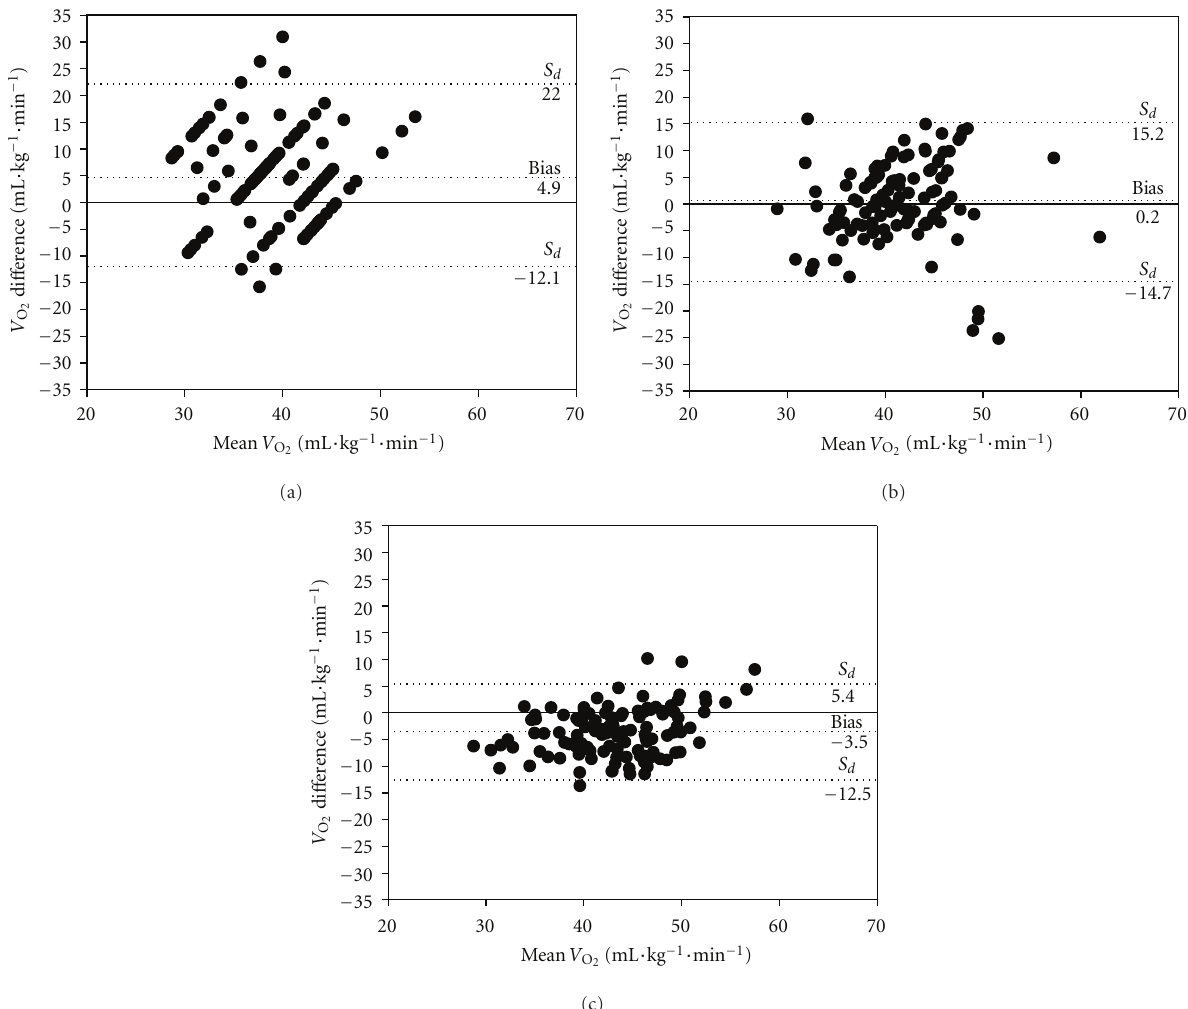
assessed in CPET1 and V O estimated by VSAQ (a), RPC (b), 2 max 2 max